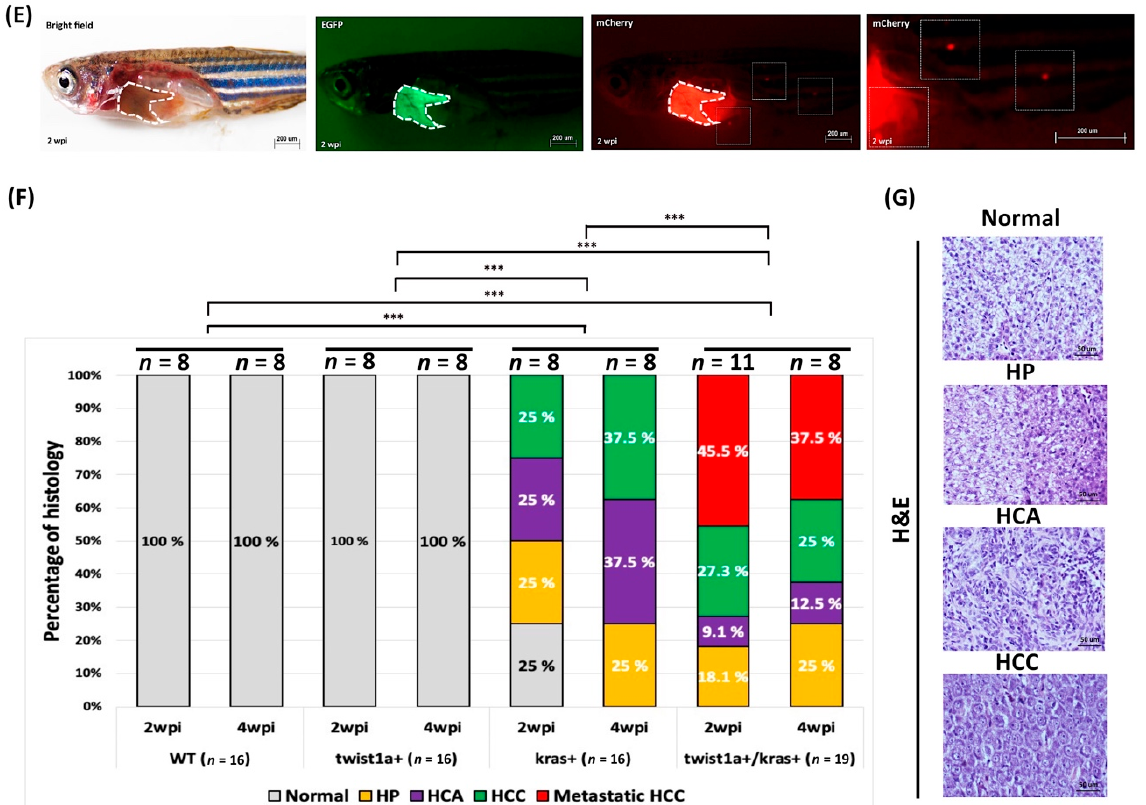
Figure 1. Induction of tumor metastasis in twist1a+/kras+ transgenic zebrafish with Dox treatment. All zebrafish were treated with 20 μ g/mL Dox and 1 μ g/mL 4-OHT at 4 mpf, and samples were taken at 2 and 4 wpi. ( A ) Representative images of wild-type , twist1a+ , kras+ , and twist1a+ / kras+ transgenic zebrafish. The left column shows the external appearance, the middle column shows the internal organs of the abdomen with the liver outlined (white dotted line), and the right column shows H&E staining of liver tissues at 4 wpi. Compared with the wild-type group, ( B ) the body lengths of kras+ and/or twist1a+ / kras+ transgenic zebrafish differed significantly at 2 and 4 wpi, whereas ( C ) the body weights of transgenic zebrafish did not differ at 2 and 4 wpi. ( D ) Kaplan-Meier survival curves showing the percentage of survival at 4 wpi. ( E ) Fluorescence analysis presenting evidence of metastatic HCC at 2 wpi in twist1a +/ kras + zebrafish (white dotted line: primary and metastatic liver tumors). ( F ) Histological analysis revealed that wild-type, twist1a+ , kras+ , and twist1a+ / kras+ transgenic zebrafish developed HCC or metastatic HCC at 4 wpi. ( G ) Representative images of normal, HP, HCA, and HCC using histological analysis. Scale bars: 50 or 200 μ m. Student’s t -test or one-way ANOVA were used to assess differences between variables: * p < 0.05, *** p < 0.001.